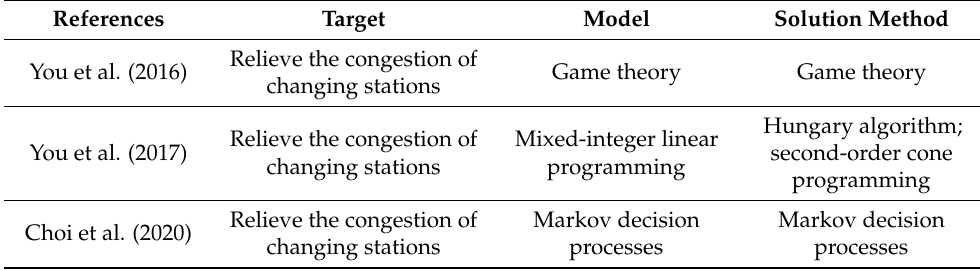
Table 5. Assignment problem of